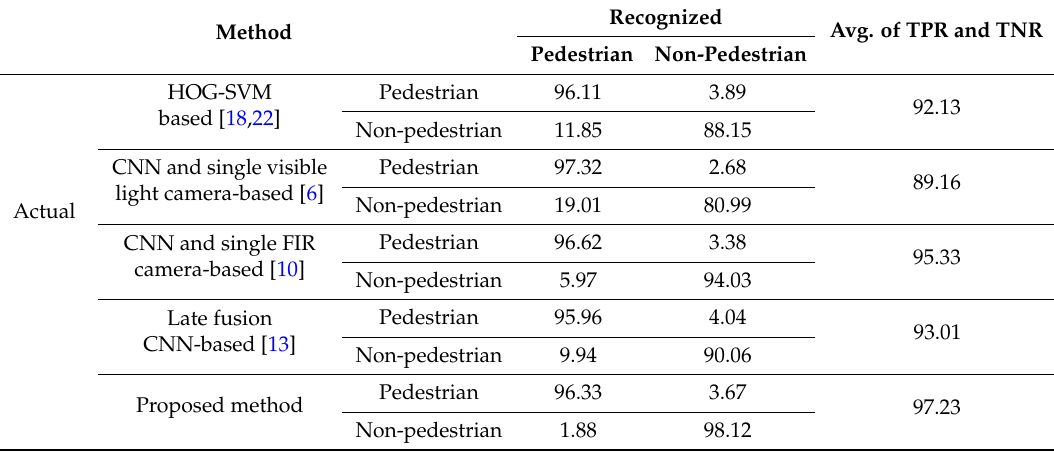
Table 10. Comparisons of classification accuracies with degraded DVLFPD-DB1 based on confusion matrix (unit: %).